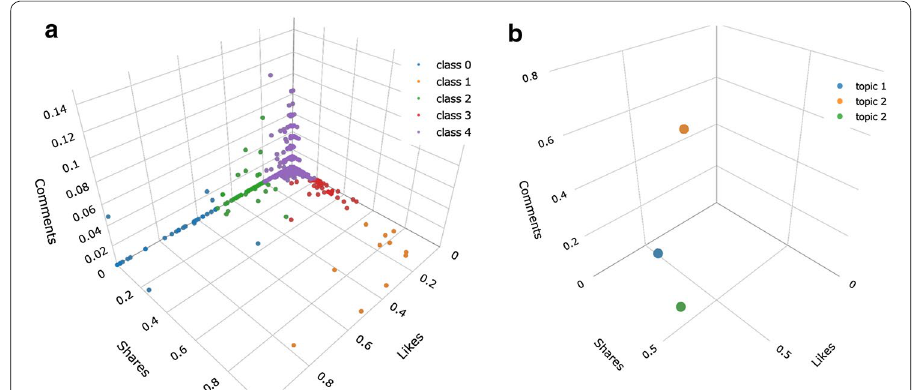
Fig. 3 Users’ reaction types: a classes of users for a charity community, b user attitude to various topics in the reaction space